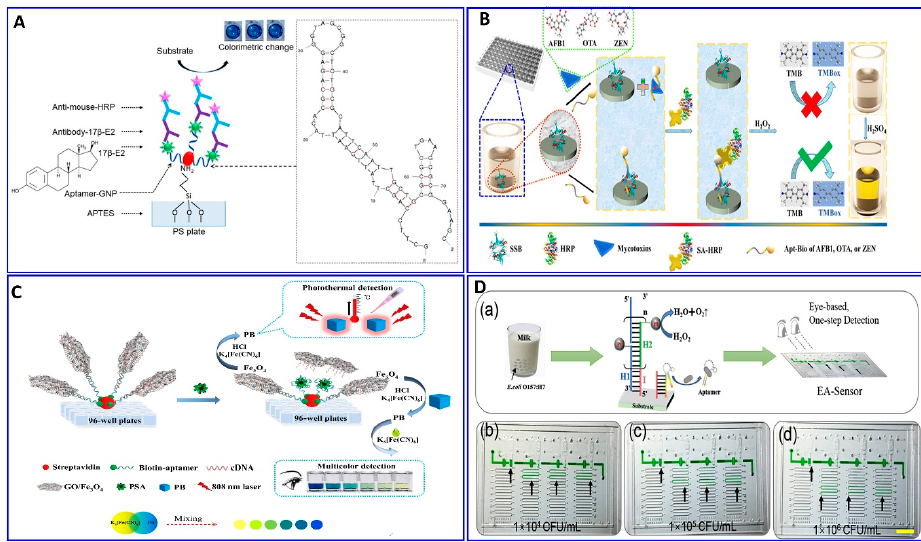
Figure 5. ( A ) Schematic illustration of the ELISA for assaying of 17 β -E2 with an assisting aptamer–antibody sandwich functionalized with AuNPs, reproduced from [109]. ( B ) Principal assay procedures for mycotoxins using a green ELISA based on a single-stranded binding protein (SSB)-assisted aptamer; the SSB was dispensed into polystyrene 96 plates; reproduced from [110]. ( C ) Schematic illustration outlining the multicolor and photothermal assay for prostate-specific antigen (PSA) via magnetic beads assisting aptamer separation, reproduced from [111]. ( D ) Detection of E.coli O157:H7 in milk via the developed naked-eye EA-Sensor, reproduced from [112].